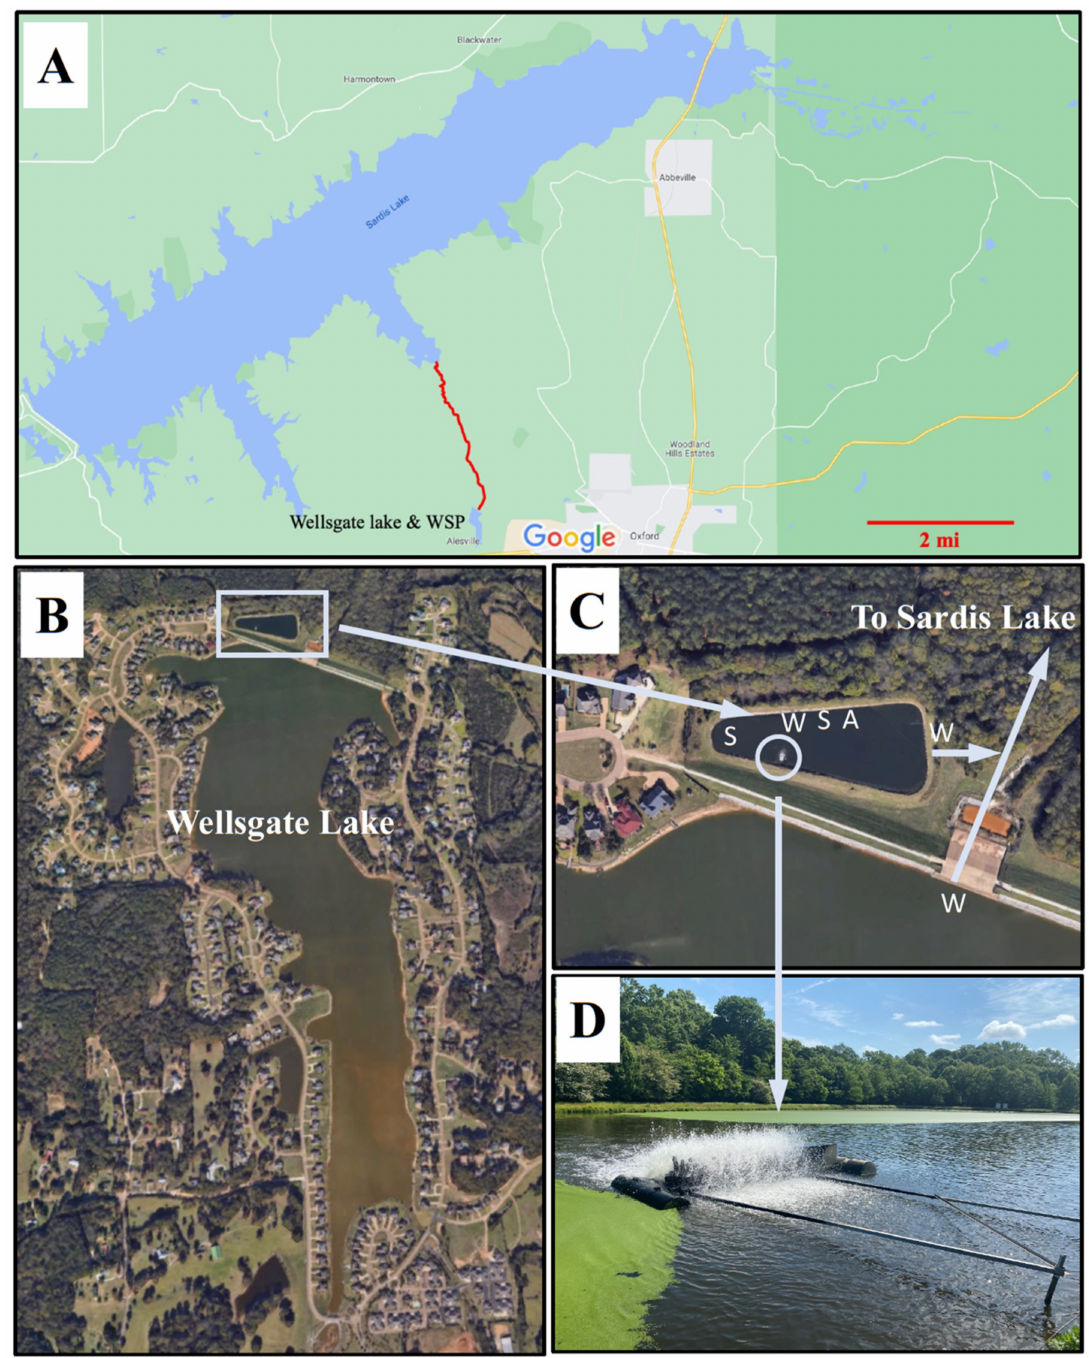
Figure 1. Study area showing ( A ) the distance and pathway (squiggly red line) from the study site to Sardis Lake downstream, ( B ) Wellsgate Lake and the surrounding community, and ( C ) overview of the WSP with arrows indicating direction of WSP discharge and overflow from lake, and ( D ) close-up photo of aeration of the WSP and surface duckweed. Letters in section ( C ) indicate the general location where samples of water (W), sludge (S), and surface duckweed (A) were collected, with the W just outside of the pond representing the effluent sampling